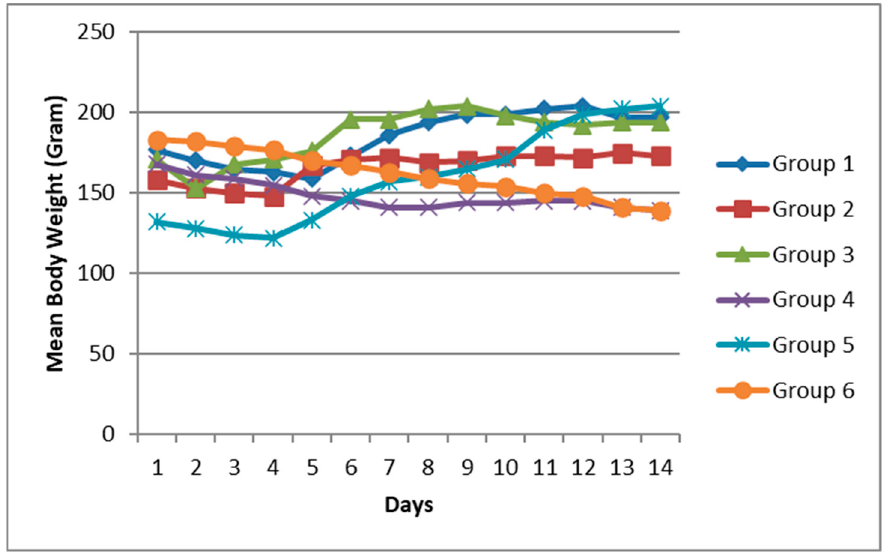
Figure 3. Mean ( n = 2) body weight of the experimental animals within 14 days.